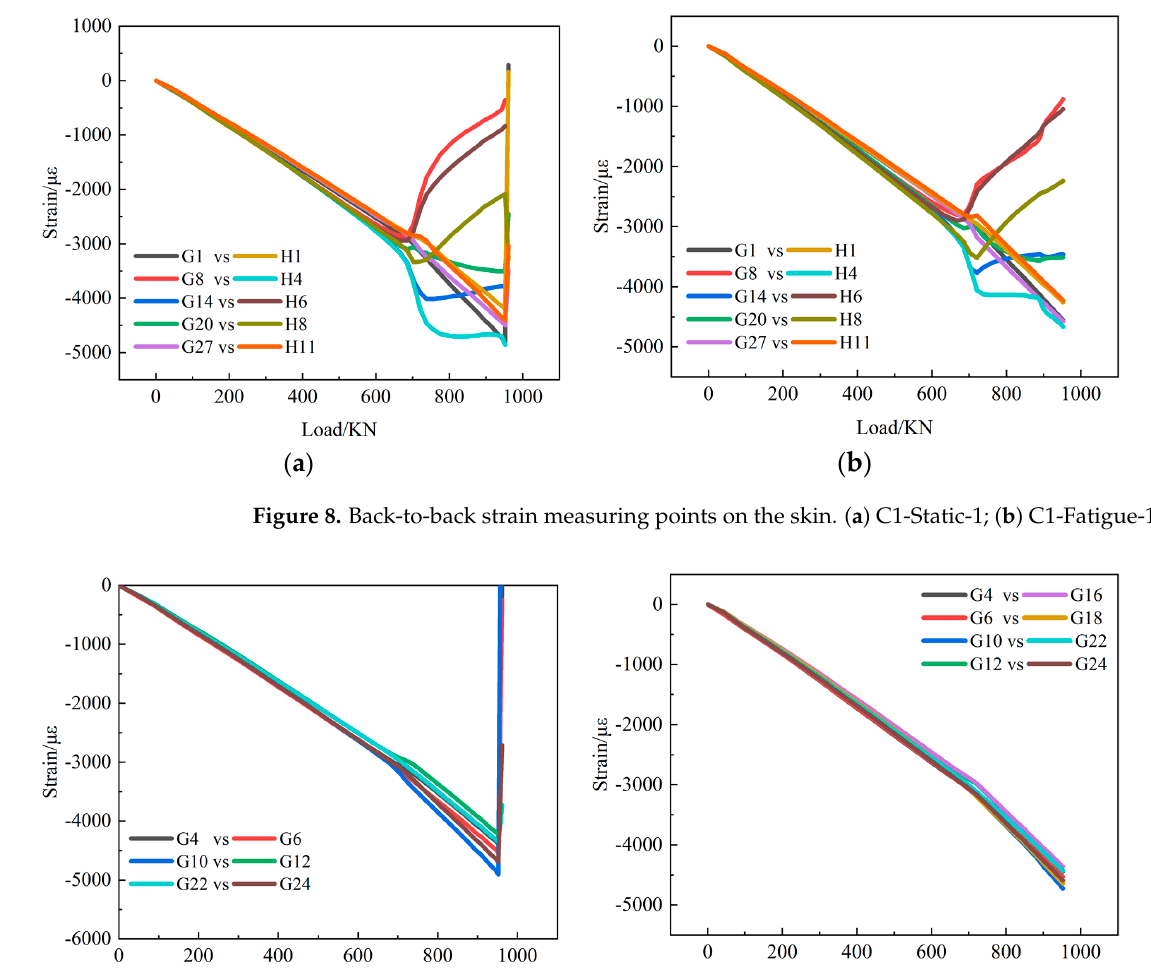
Table 7. Buckling load and failure load for all the specimens.